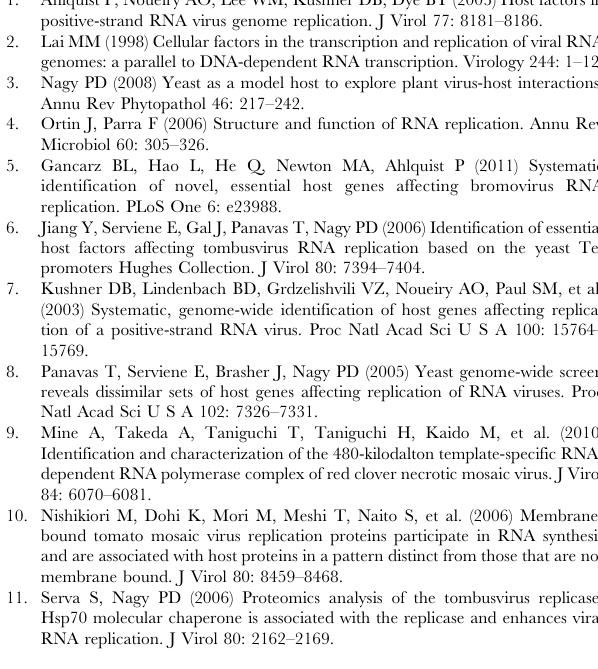
the control and NbHsp90-silenced plants at 2 or 6 dpi. All data are mean averages of three experiments and normalized against those of TRV1/TRV2 control plants. (TIF) Figure S4 Inhibition of NbHsp90 with GA and 17-AAG treatments reduces BaMV RNA accumulation in N. benthamiana protoplasts. Quantification of relative accumu- lation of BaMV, PVX, and CMV viral RNAs in control and Hsp90 inhibitor-treated protoplasts was shown. The data are mean averages of three independent experiments and normalized against those of DMSO-treated control protoplasts. (TIF) Figure S5 Effect of 17-AAG on satBaMV RNA accumu- lation in protoplasts. The relative accumulation of satBaMV RNA in protoplasts treated with DMSO or 17-AAG at various concentrations as indicated at the bottom. The satBaMV RNA accumulation concentration in DMSO treated protoplasts is designated as 100%. The data represent the mean averages of three independent experiments and standard deviations are indicated. (TIF) Text S1 Details for plasmid construction and recombi- nant protein